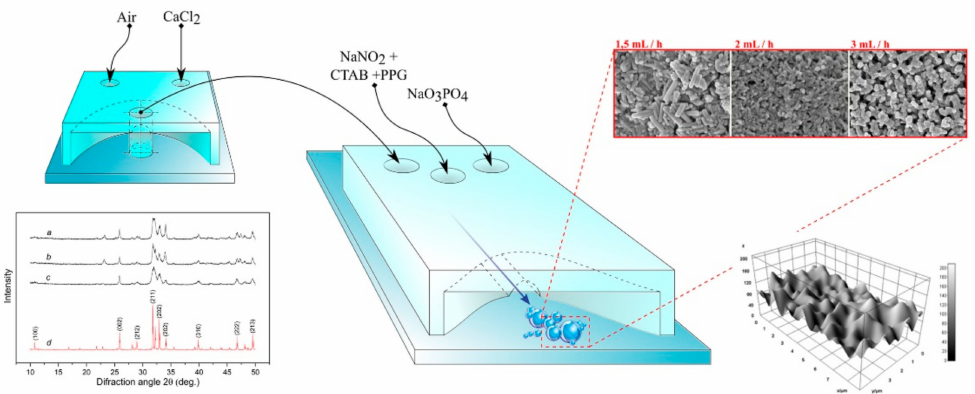
Figure 5. Schematic of the microfluidic device used for HAP nanoparticles production. The SEM images show the different materials obtained at different flow rates, as well as the surface roughness. With permission from Elsevier. https://doi.org/10.1016/j.msec.2019.04.037 (accessed on 8 April